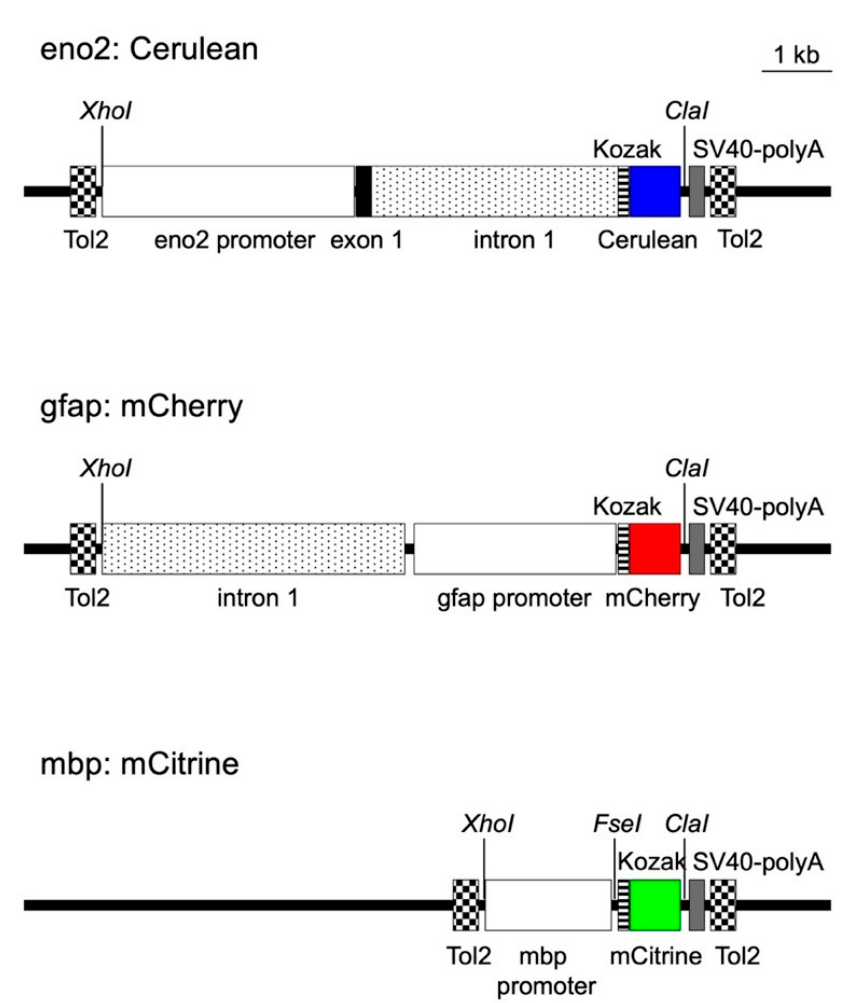
Figure 1. Schematic representation of transposon vectors.